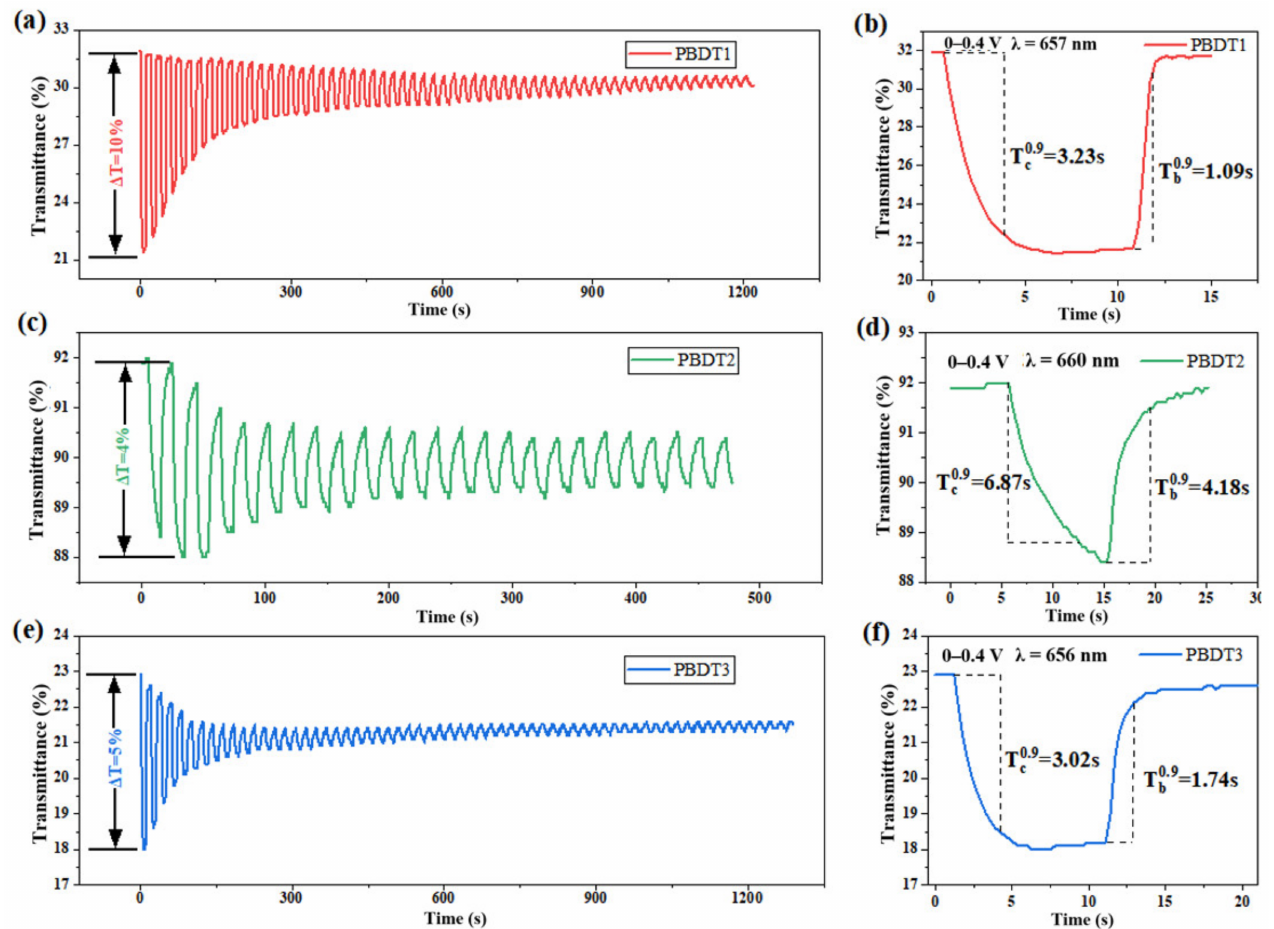
Figure 6. Cyclical stability and switching time of ( a , b ) PBDT1-DTBF and ( c , d ) PBDT2-DTBF and ( e ), and ( f ) PBDT3-DTBF processing from